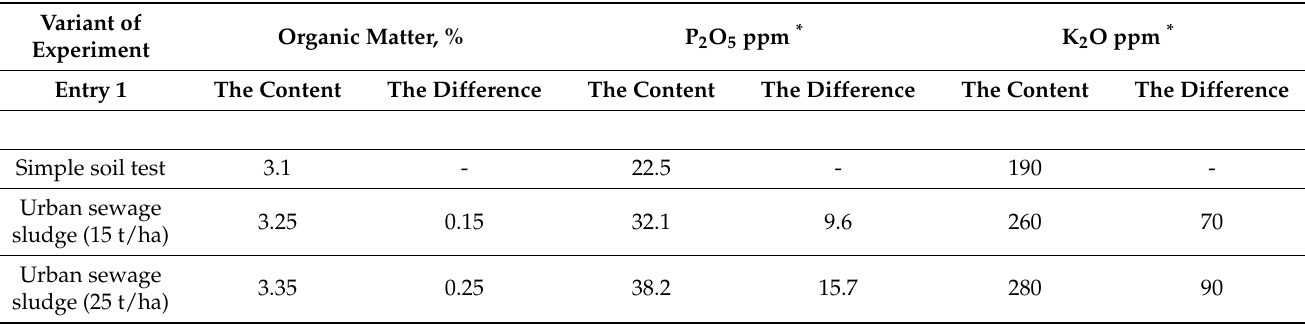
Table 5. The effect of the content of organic matter, the forms of phosphorus and potassium from the soil under the influence of the application of urban sewage sludge resulting from the treatment of wastewater from the Municipality of Alexandria,